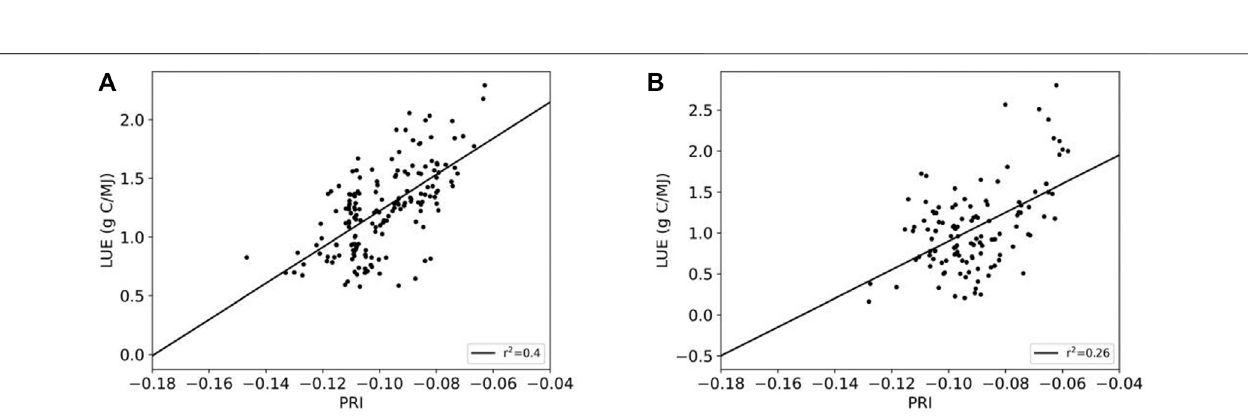
FIGURE 5 | Correlation between PRI and LUE on sunny days (A) and cloudy days (B) with the OZA of 0 ° .